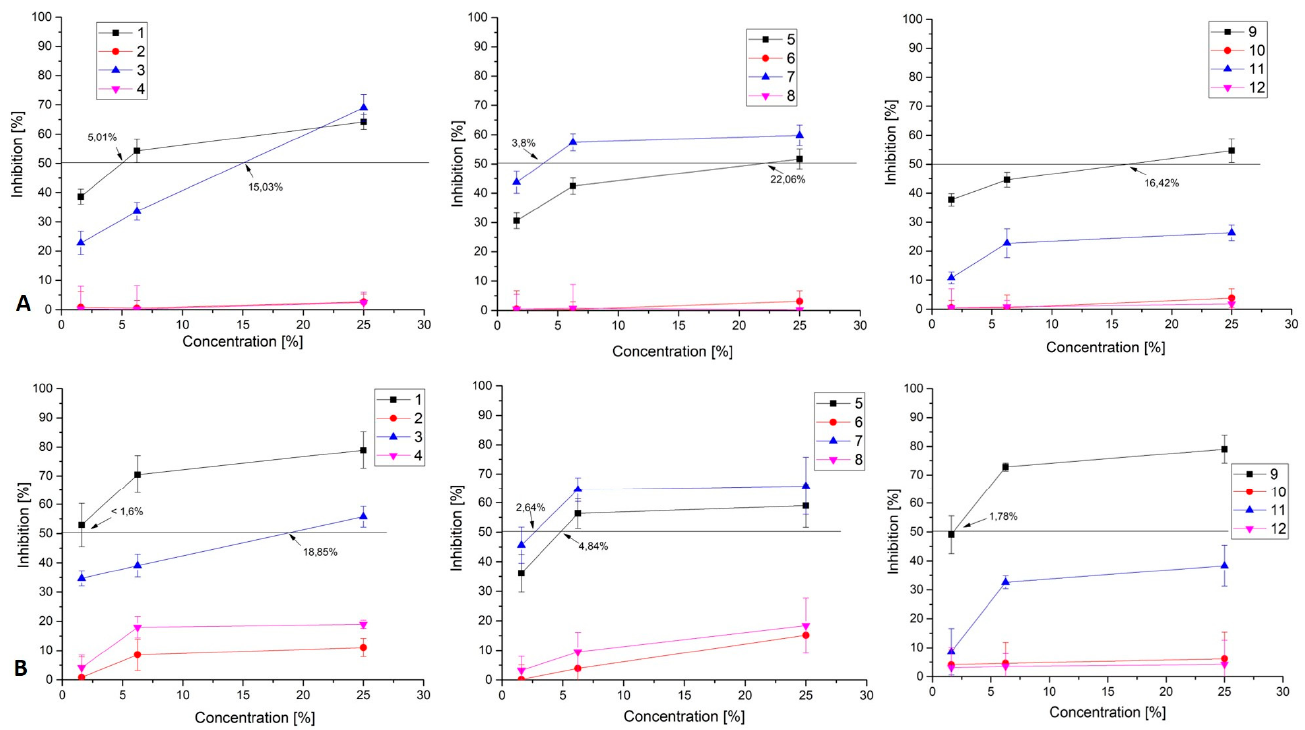
Figure 2. Antiviral activity of CFSs from the studied LAB strains 1. KC 5-12, 2. KC 5-13, 3. KC 5-14, 4. KZC 8-21-1, 5. KZC 8-23-5, 6. C 10-31-3, 7. KO 4-4, 8. KO 3-7-5, 9. KZM 2-11-3, 10. KZM 2-11-1, 11. KZM 2-11-3 (SM), 12. KZM 2-11-1 (SM) against ( А ) HHV 1 and ( B ) HHV 2.